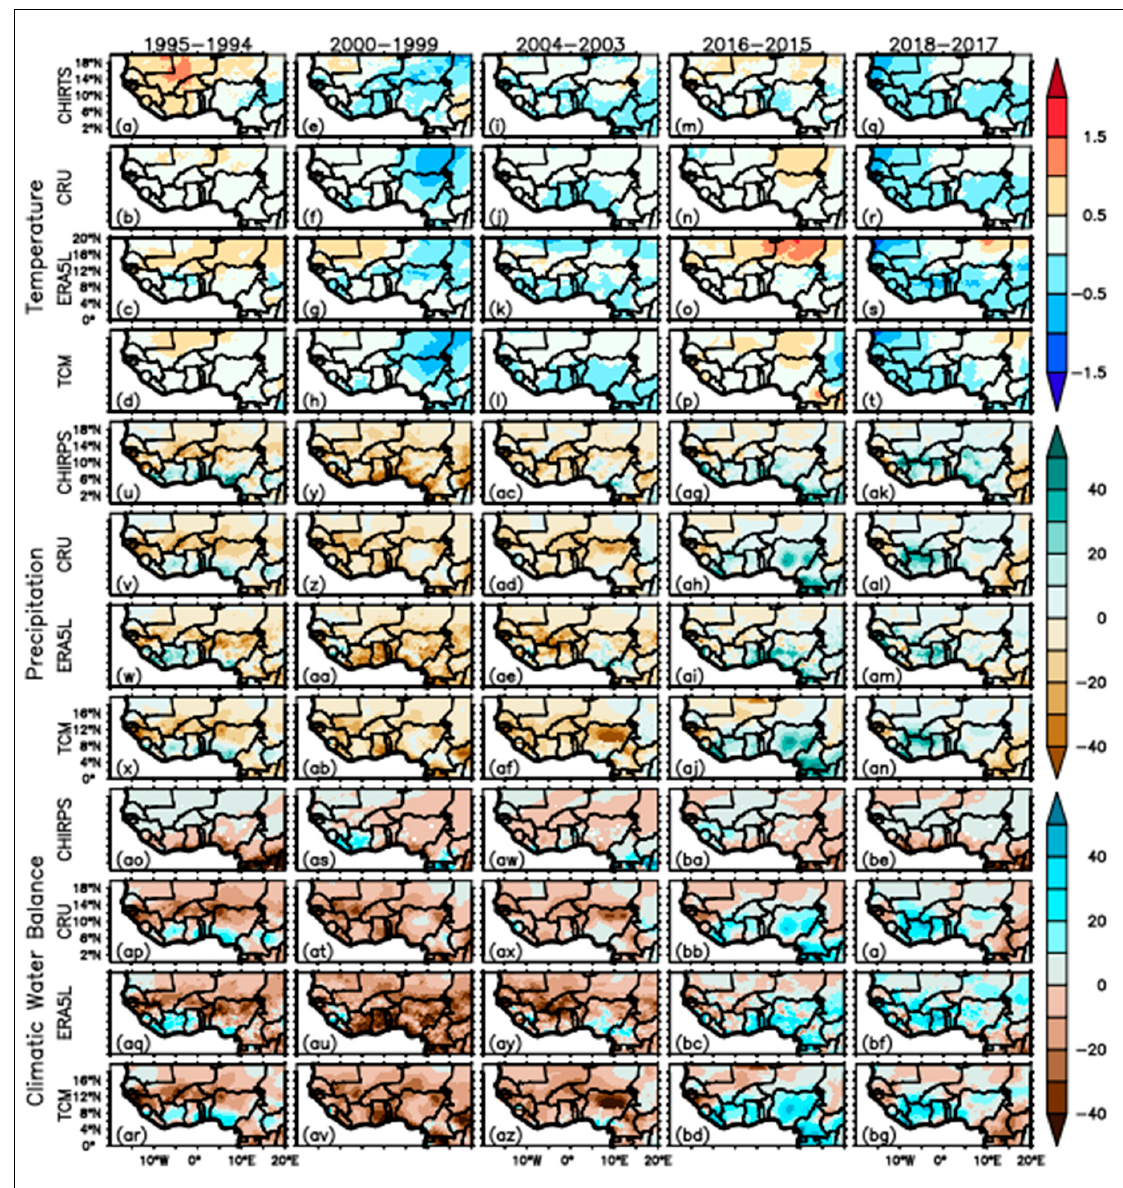
Figure 9. ( a–bg ) Changes in temperature, precipitation, and climatic water balance leading to high land cover area change. land cover area